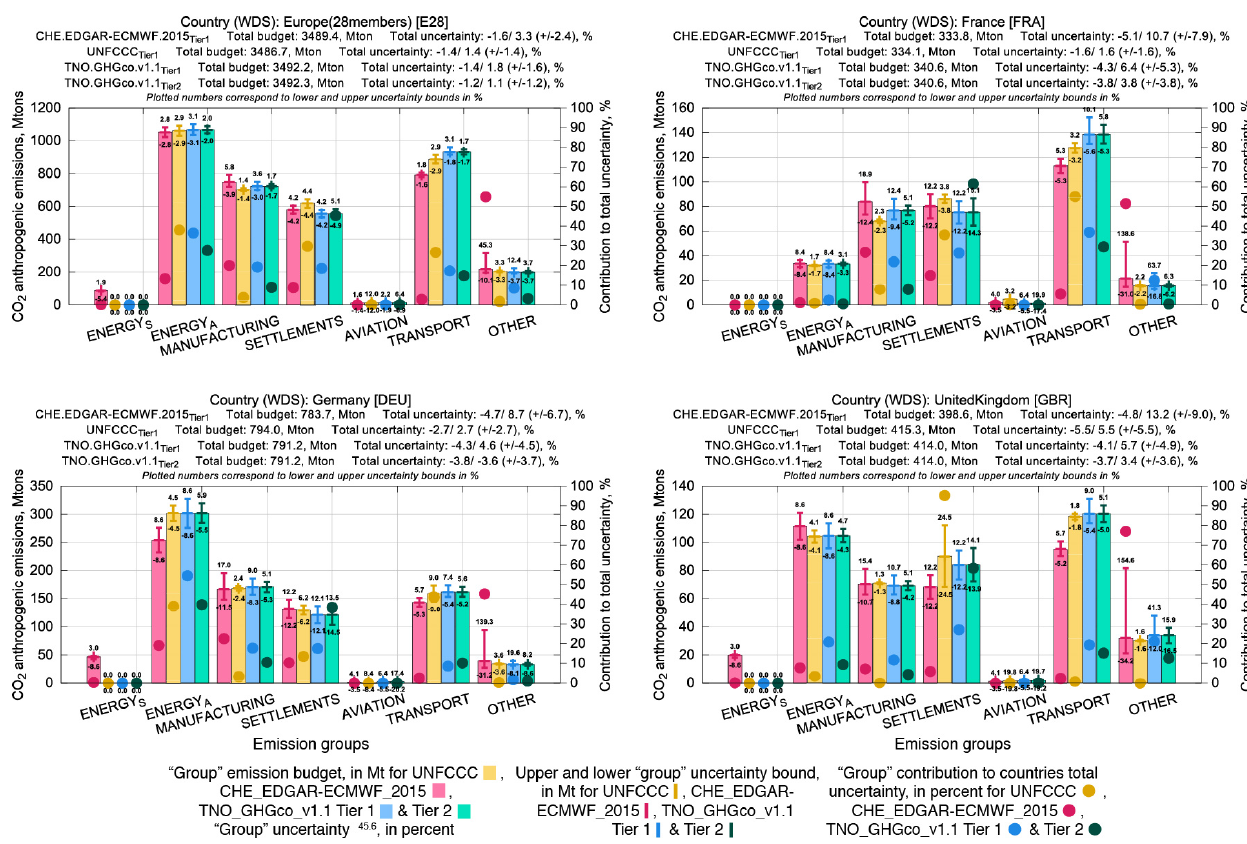
Figure 9. Emission budgets, uncertainties, and contributions in percentage to the total uncertainty for Europe (E28), Germany (DEU), France (FRA), and United Kingdom